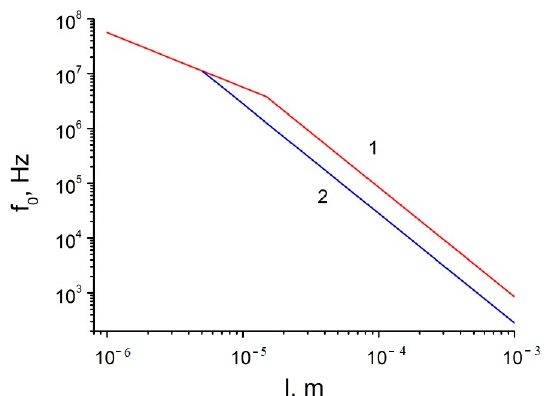
Figure 4. Dependence of ME natural oscillation frequency on its length at ME thicknesses (1) of 1.5 μ m and (2) 0.5 μ m. 1.5 µ m and (2) 0.5 µ